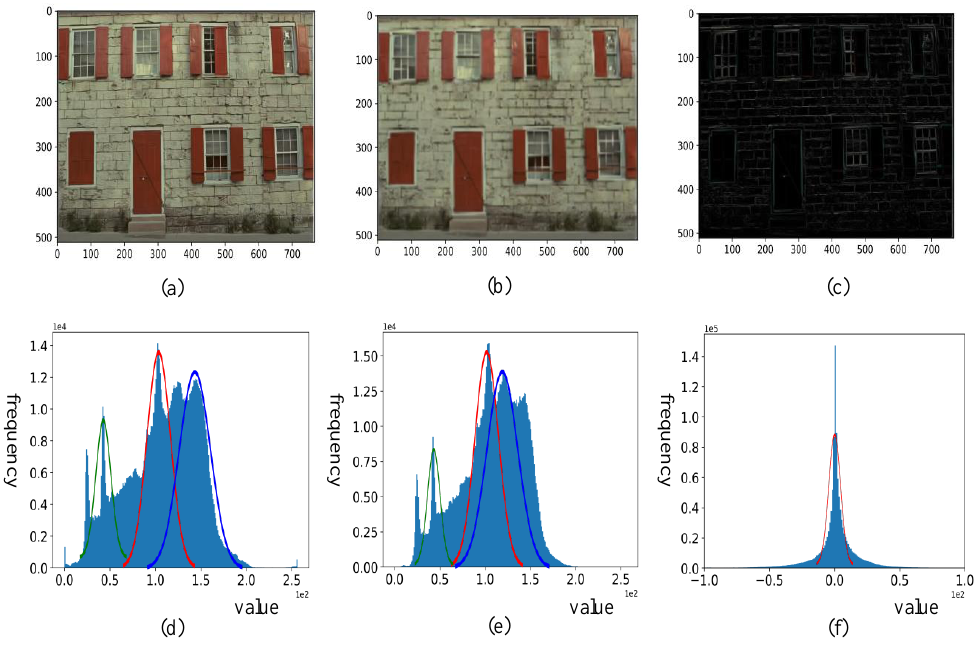
Figure 1. Images and the corresponding histograms: ( a ) original; ( b ) reconstruction; ( c ) residual; ( d ) original histogram; ( e ) reconstruction histogram; and ( f ) residual